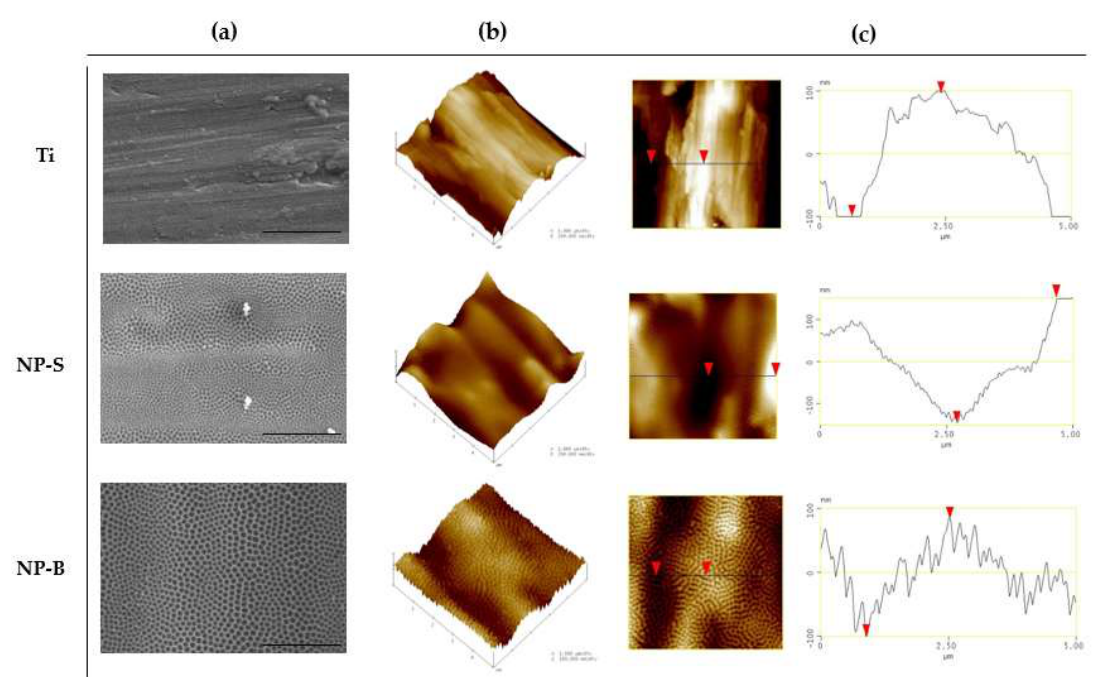
Figure 1. Surface characterization by scanning electron microscope (SEM) and atomic force microscopy (AFM) images of nanoporous arrays (NP-S, NP-B) and the Ti control surface. ( a ) SEM images of the surfaces (scale bar = 2 µ m). ( b ) Three-dimensional reconstructions based on 5 µ m × 5 µ m scans obtained by AFM. ( c ) Two-dimensional images and cross-sectional profiles obtained by AFM. Red triangle represented the highest and lowest position of the surface.